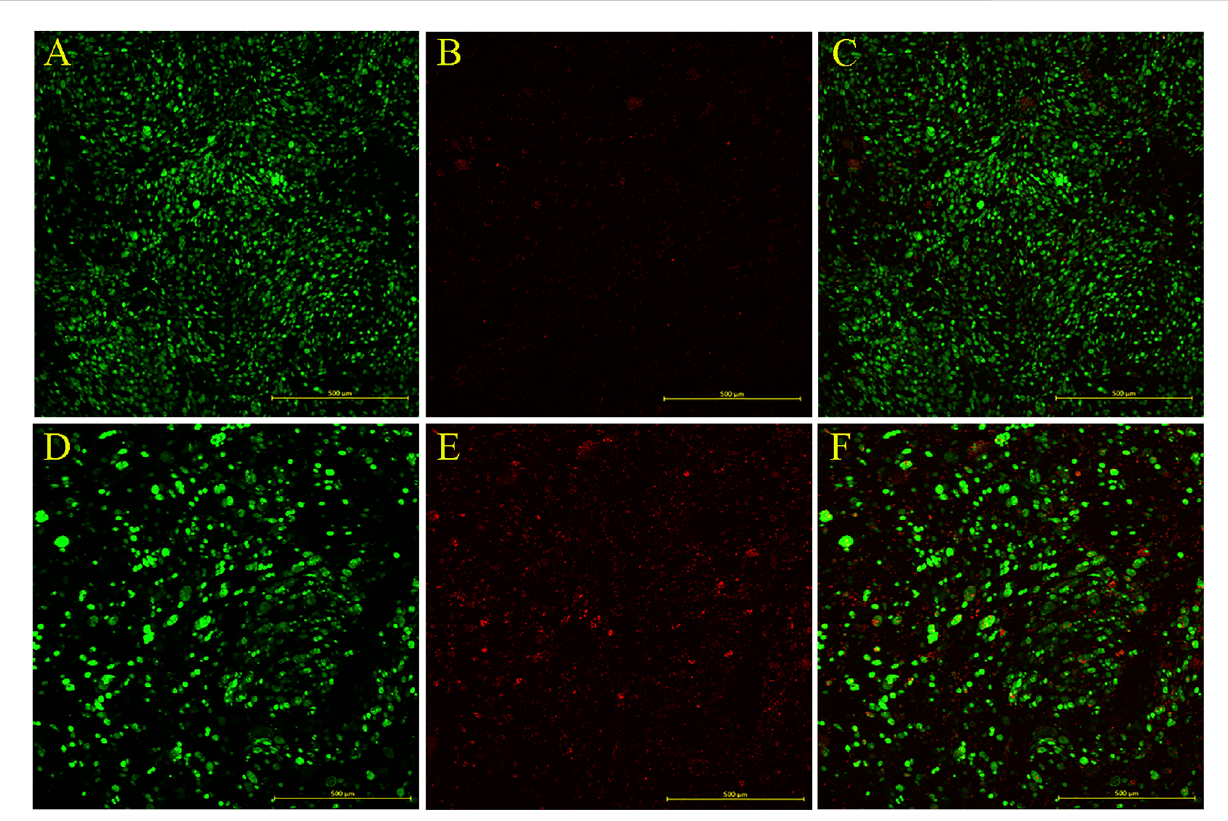
FIGURE 14 Bioprintedconstruct viability and maintenance:4%alginate and 3%gelatin with 107cells/mL oftheHepG2 bioprinted construct on day0 (A – C) and incultureafter 7 days (D – F) .Green: CalceinAM;Red: PI(Propidiumiodide).AxioObserverZeissmicroscope.Constructsize: 1.42 mm×1.42 mm — (A –